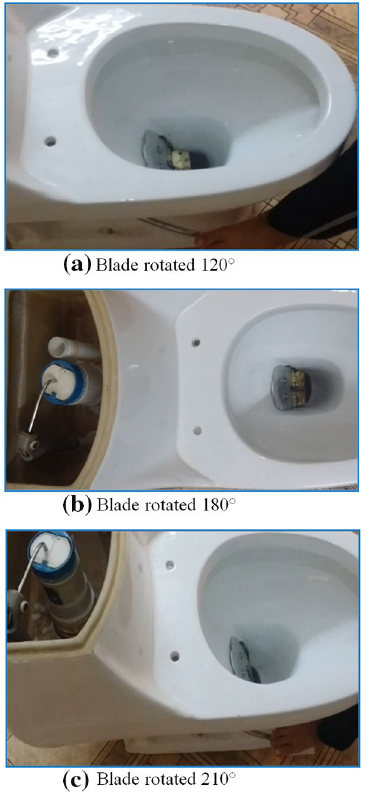
Fig. 6 Steps of moving down perforated rotatable